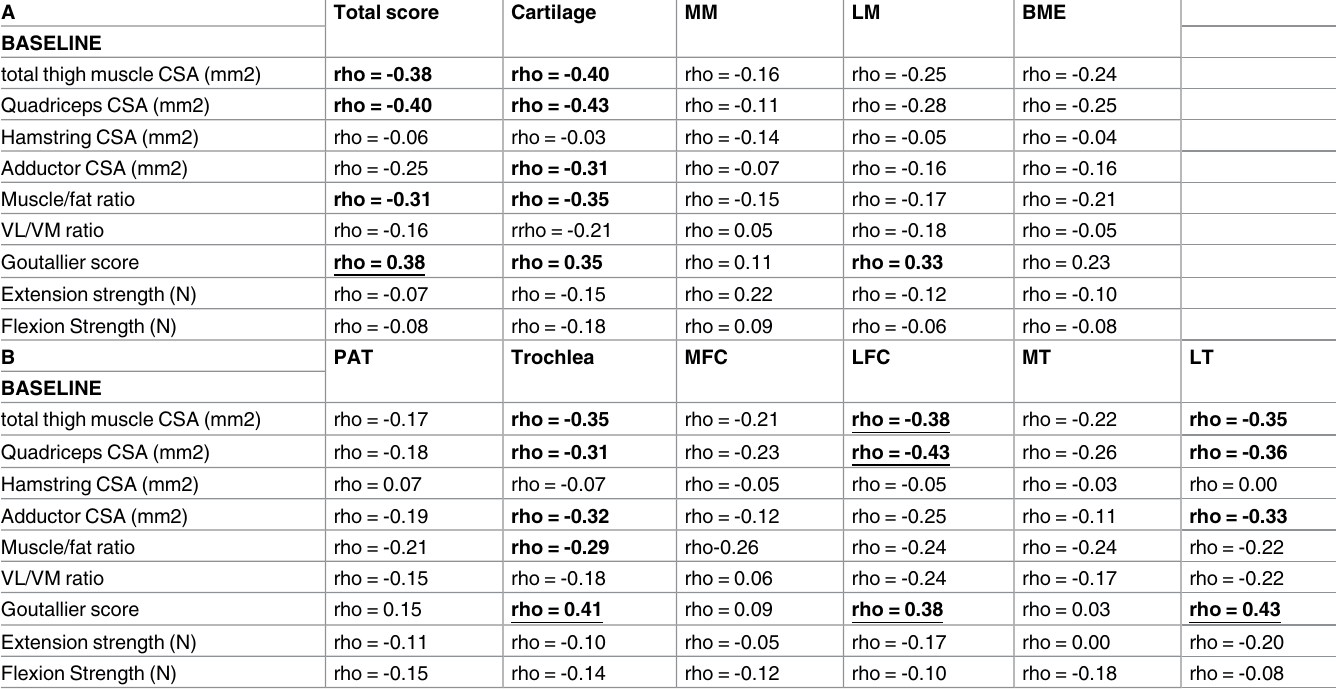
Table 4. Partial spearmancorrelations of muscle characteristics.